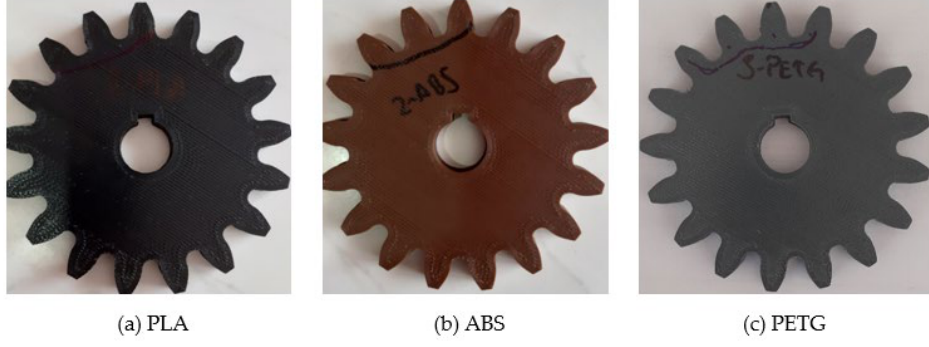
Figure 4. Polymeric spur gears ( a ) PLA, ( b ) ABS, ( c ) PETG.